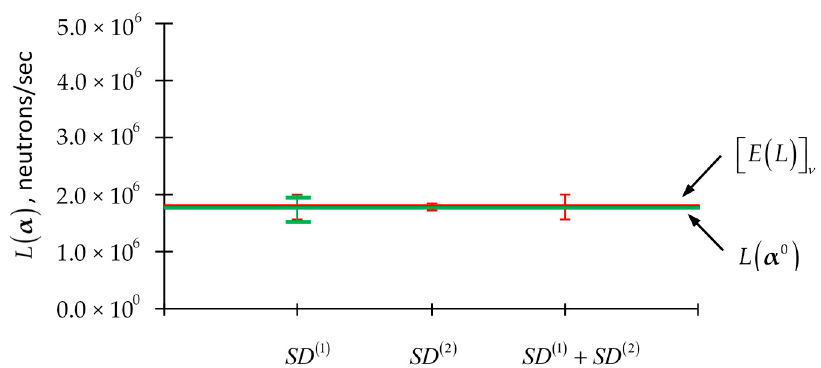
Figure 13. Comparison of (cid:16) (cid:17) ± SD ( 1 ) (in green), [ E ( L )] ± SD ( 1 ) , SD ( 2 ) , SD ( 1 ) + SD ( 2 ) (in red), due to 5% standard deviations of the uncorrelated isotopic number densities.